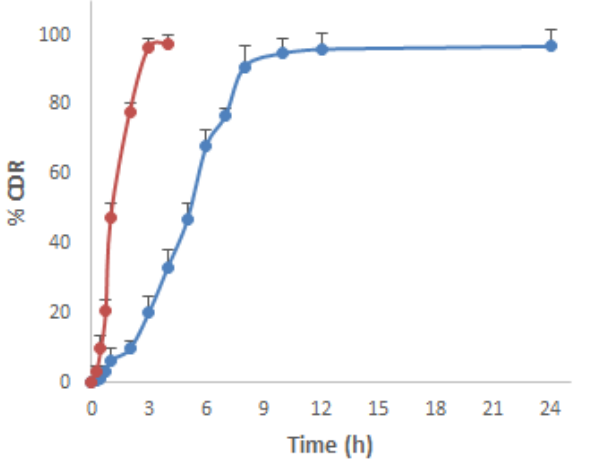
FIGURE 2 - In vitro release profile of pure drug and optimized